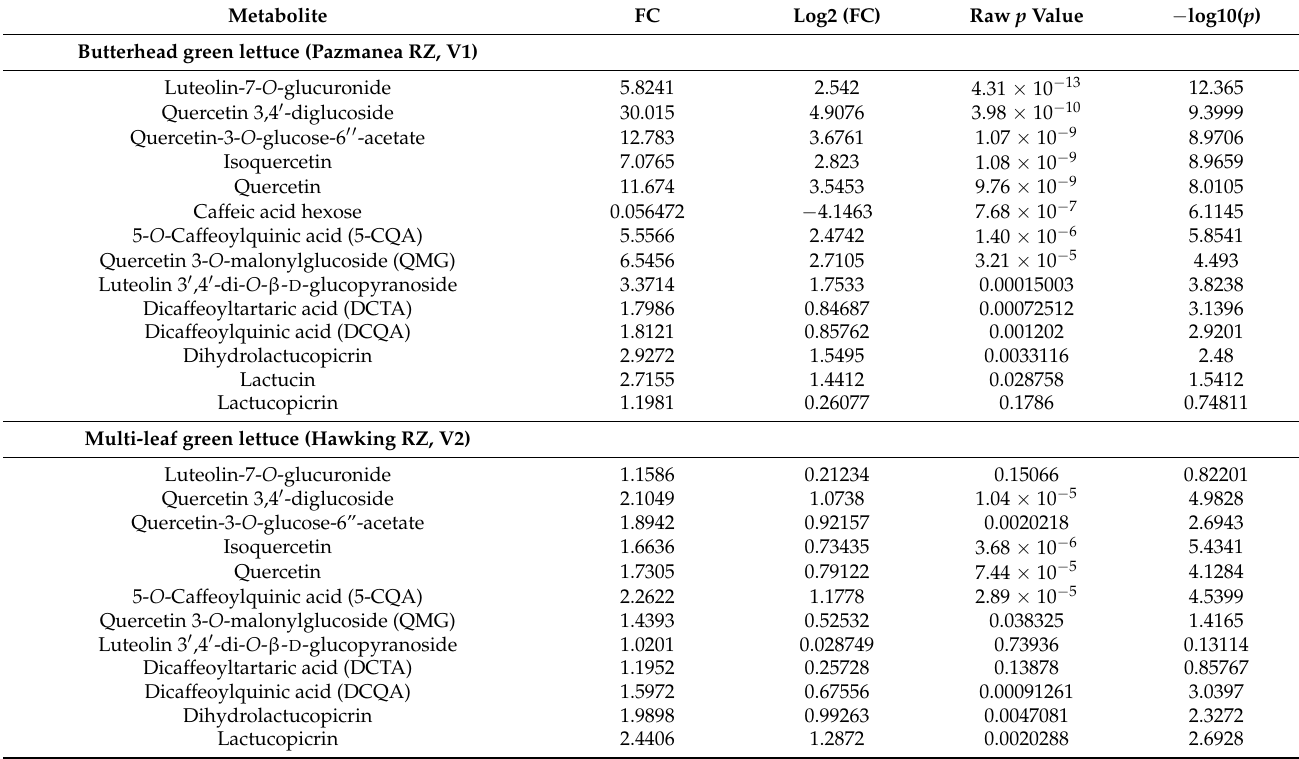
Table 4. Fold change ( − S/+S) and p -values of these 14 identified metabolites of butterhead green lettuce (V1) and multi-leaf green lettuce